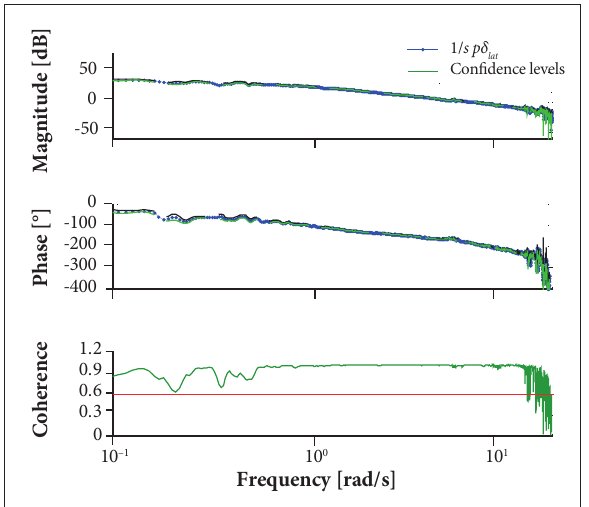
Figure 12. Bode diagram and coherence function for lateral cyclic